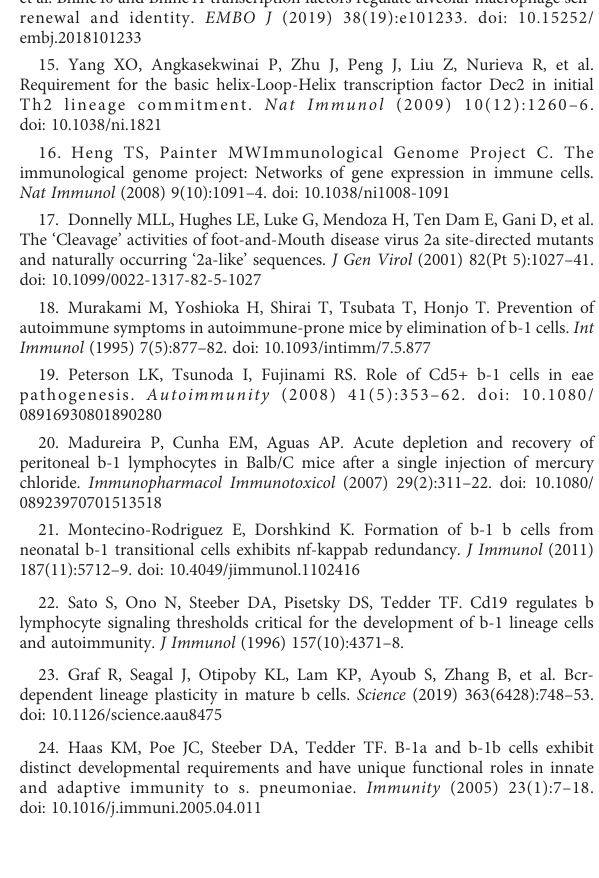
SUPPLEMENTARY FIGURE 4 Bhlhe41 is expressed in neonatal splenic CD19 hi cKit + Sca1 + B-1 progenitors. Splenic B cells from neonatal Bhlhe41 +/+ and Bhlhe41 dTomato-Cre/+ mice at postnatal day 7 were analyzed by fl ow cytometric analysis. SUPPLEMENTARY FIGURE 5 Cre-mediated DNA recombination in alveolar macrophage, microglia, and thymocytes by Bhlhe41 dTomato-Cre mice. Flow cytometric analysis dTomato and EYFP in (A) alveolar macrophage, (B) microglia, and (C) thymocytes from adult Bhlhe41 +/ + and Bhlhe41 dTomato-Cre/ + Rosa26 EYFP mice. The gating strategy for each type is illustrated on the left panel. DN, double negative; DP, double positive; SP, single positive; BALF, bronchoalveolar lavage fl uid; CNS, central nervous system. SUPPLEMENTARY FIGURE 6 Purity of sorted CD19 + dTomato + B cells from neonatal Bhlhe41 dTomato- Cre mice . Splenic CD19 + dTomato + B220 hi CD43 lo and CD19 + dTomato + B220 lo CD43 hi B cells were puri fi ed from neonatal Bhlhe41 dTomato-Cre mice at postnatal day 7 by fl ow cytometric sorting. The purity of sorted cells was analyzed by fl ow cytometric